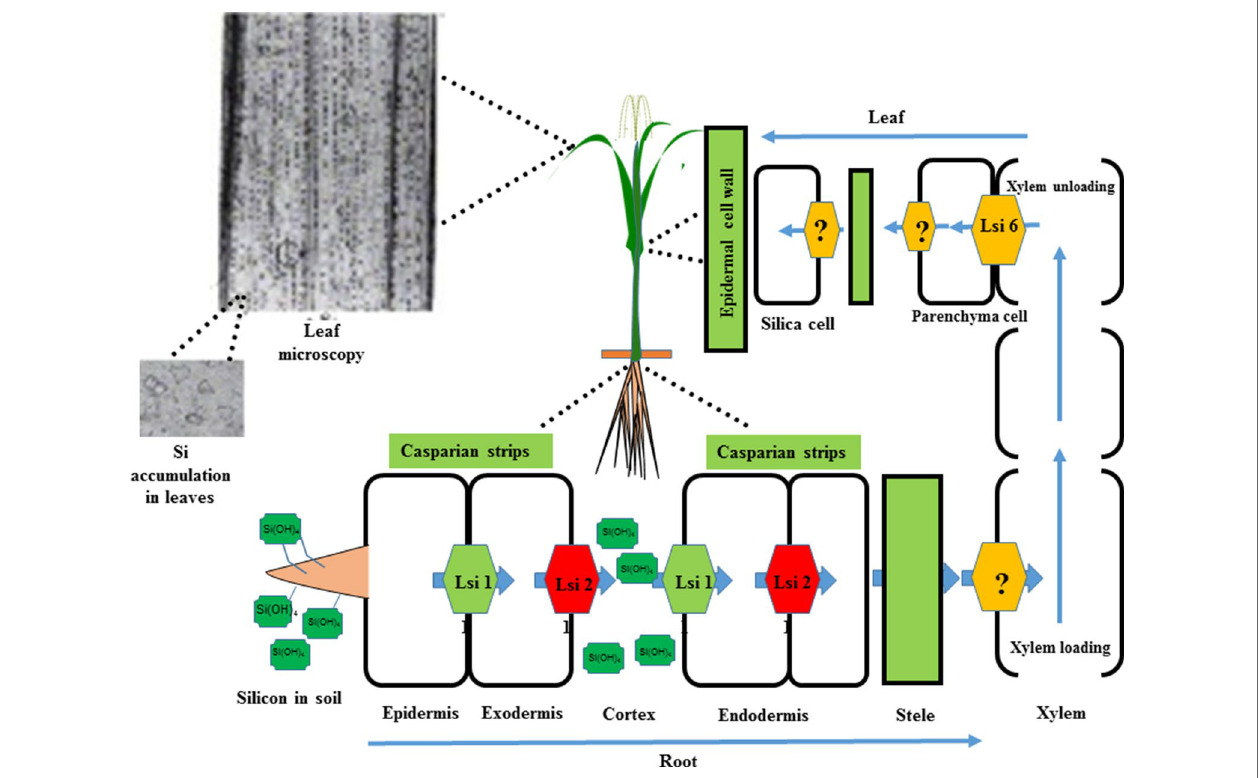
FIGURe 3 | A schematic representation of Si uptake, transport, and accumulation in rice. Silicic acid from the soil solution is absorbed by the roots and transported to the root exodermis by the influx transporter ( Lsi1 ) and subsequently released to the apoplast by the e ffl ux transporter ( Lsi2 ). Subsequently, it enters the root endodermis via Lsi1 and is released to the stele portion of the root via Lsi2 . Finally, silicic acid is translocated by an unknown transporter into the xylem and transported to the shoots via the transpiration stream. In the leaves, silicic acid is unloaded by another influx transporter ( Lsi6 ) and localized in the xylem parenchyma cells of leaf sheaths and leaf blades. In the shoots and leaves, Si is transformed from an aqueous form (silicic acid) to solid amorphous silica (SiO2– nH2O) and primarily deposited in the cell walls of different tissues, such as leaf epidermal cells. Modified from Yan et al. (2018).